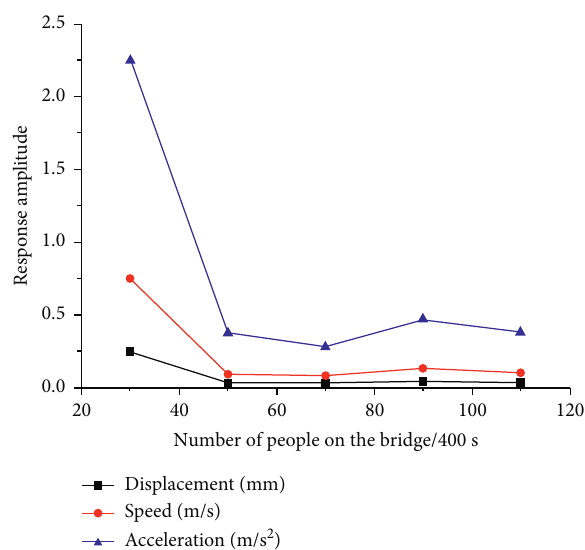
Figure 10: The relationship between lateral response amplitude of the Millennium Footbridge and damping